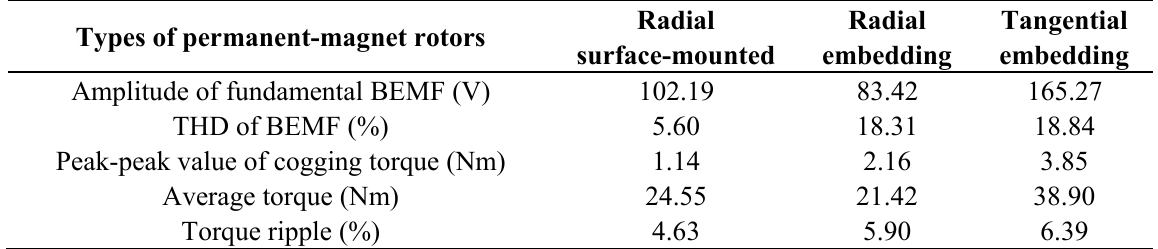
Table 2. Comparison between different permanent-magnet